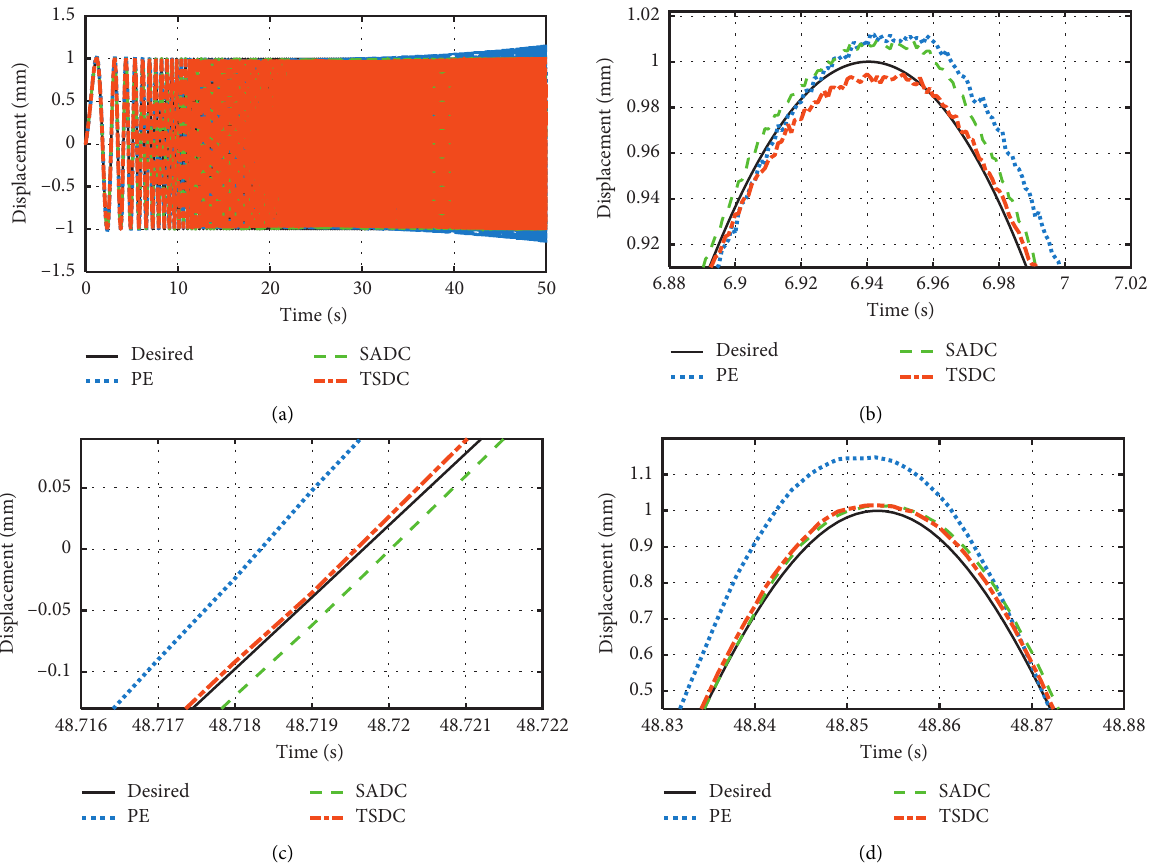
Figure 7: Comparison of measured displacements with different compensation methods. (a) Global view. (b) Close-up view of the earlier phase. (c) Close-up view of zero-displacement points of the later phase. (d) Close-up view of one peak of the later